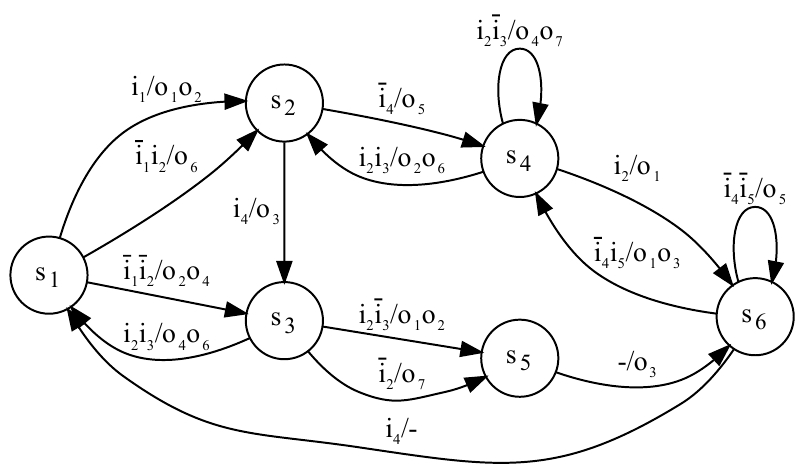
Figure 1. State transition graph of Mealy FSM A 0 .